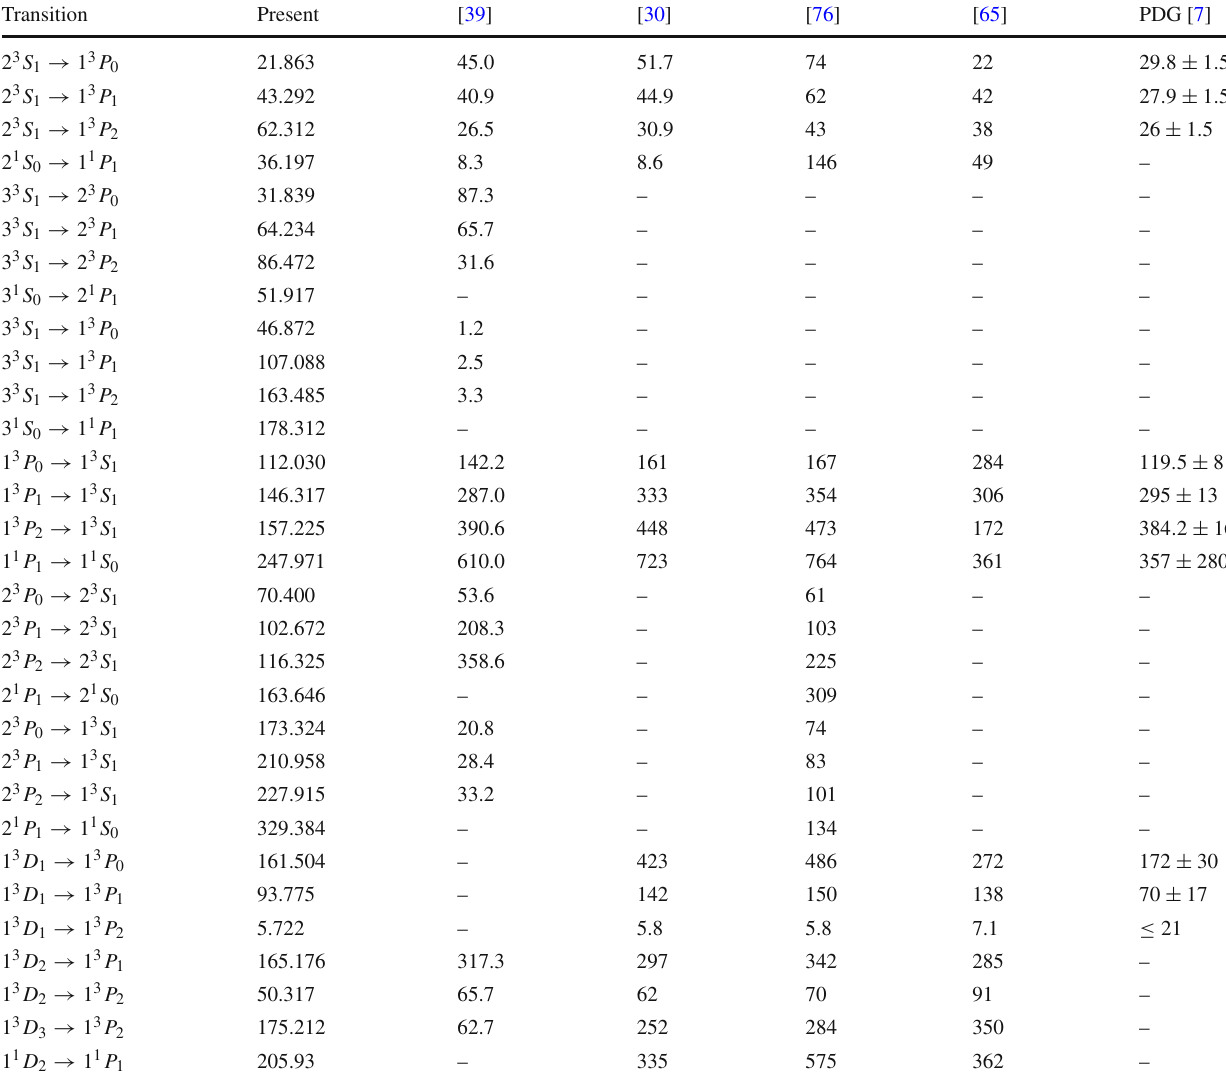
Table 20 E 1 transition width of charmonia (in keV)